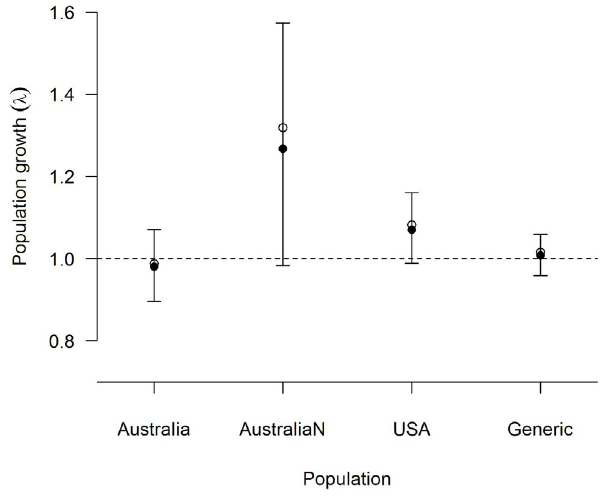
Figure 2. Asymptotic population growth rates ( l ) for three red fox populations and a ‘generic’ population. The figure shows point estimates, determined from the dominant eigenvalue of the population’s projection matrix (open circles), as well as mean (filled circles) and 95% confidence intervals (error bars) determined from 10 4 Monte Carlo resamples from the likelihood distributions of all underlying parameters. The line at l =1 indicates stability.